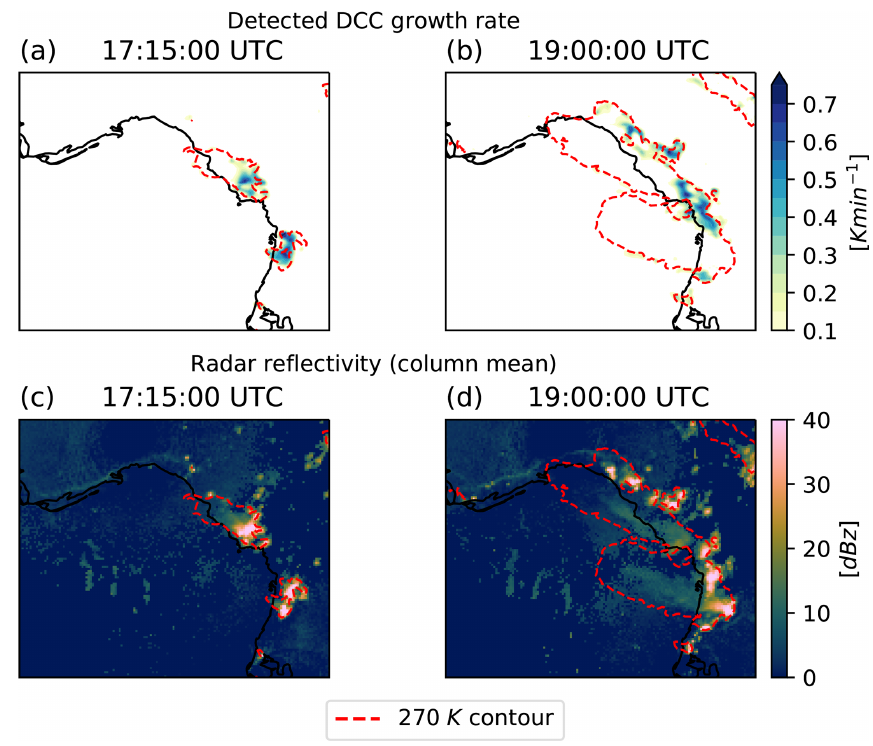
Figure 6. Detection of growing deep convective cloud regions for the DCC cluster in Fig. 1. 15min average cooling rate in the GOES-16 ABI water vapour difference field is used to detect growing cores. This is effective in the growing phases of convection (a) , but becomes less effective during the mature phase (b) . Comparison with NEXRAD column mean radar reflectivity remapped to the ABI grid (c, d) . An average cooling rate of greater than 0.5Kmin − 1 is indicative of a growing convective